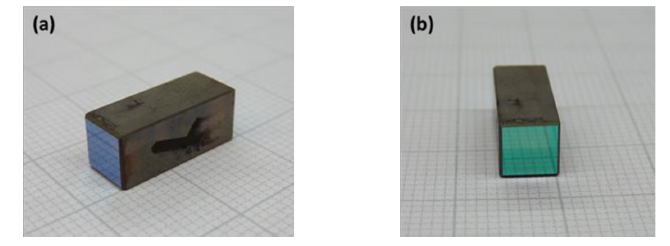
Figure 1. Photograph of the BGSe crystal: ( a ) side view and ( b ) end